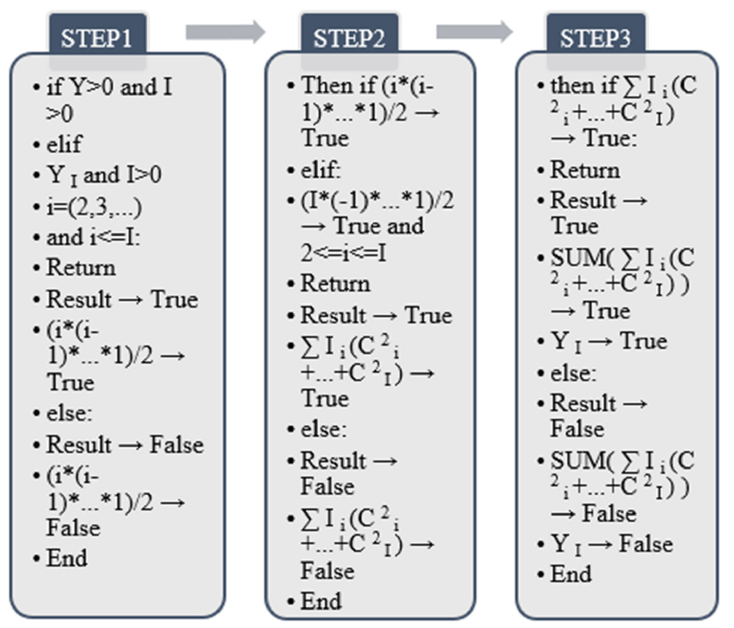
Figure 14. RNN algorithm